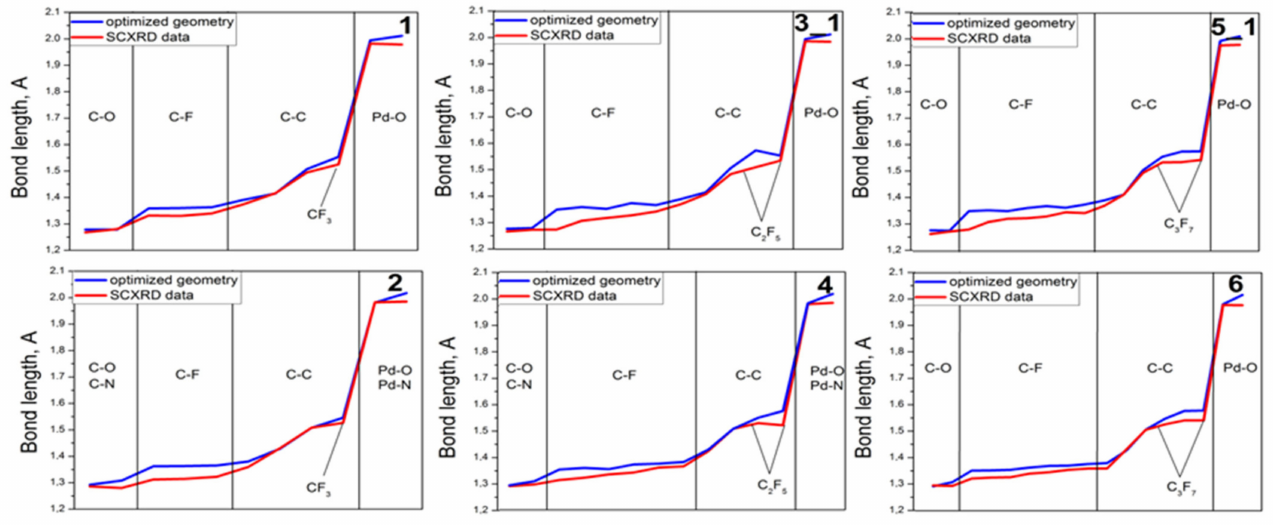
Figure 8. Comparison of bond lengths in the molecules of complexes 1 – 6 in the crystal lattice (SXRD data) and in the gas phase (optimized